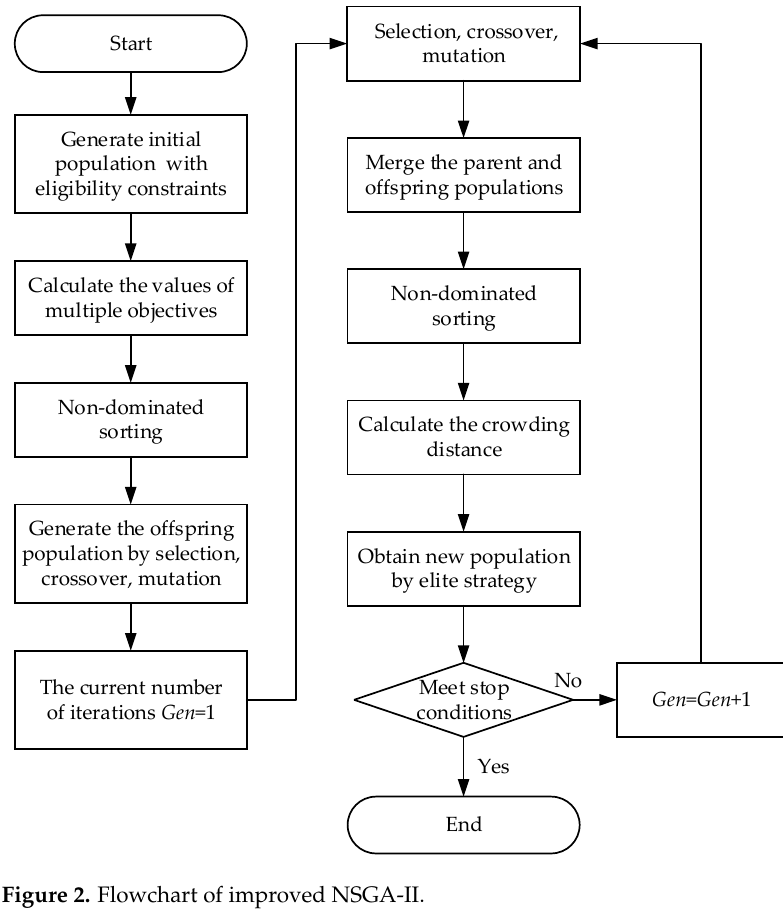
Figure 2. Flowchart of improved NSGA-II.